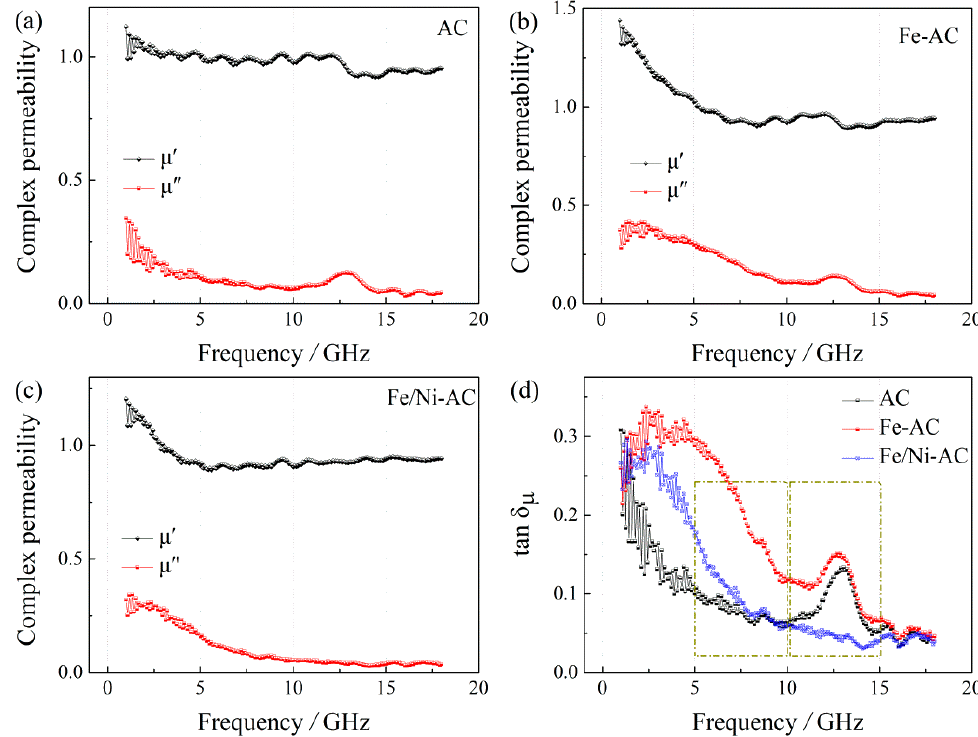
Figure 8. Complex permeability ( µ r ) of real parts ( µ ′ ) and imaginary parts ( µ ″ ) of: ( a ) AC, ( b ) Fe-AC, and ( c ) Fe/Ni-AC, and ( d ) their tan δ µ = µ ″ / µ ′ .